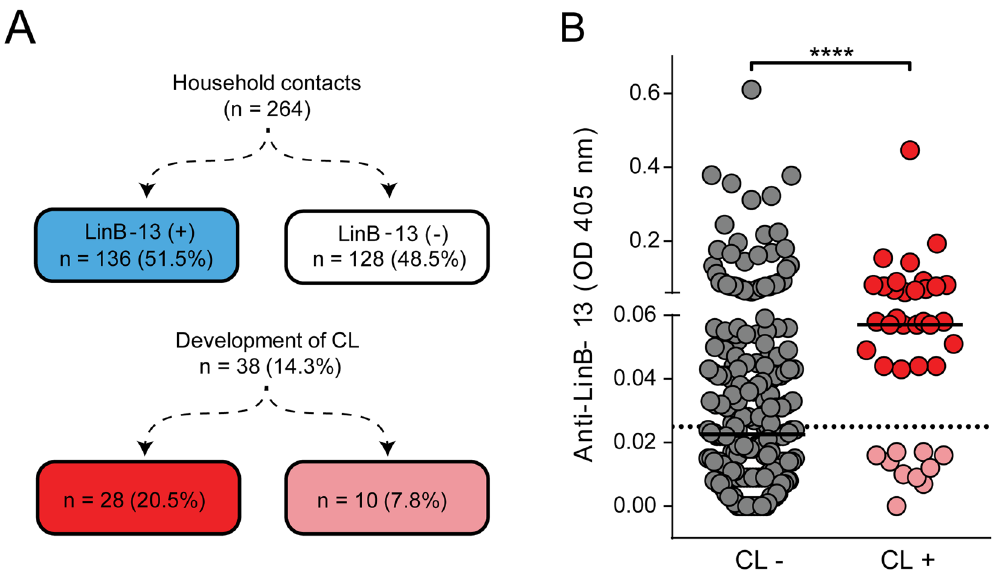
Figure 6. LinB-13 acts as risk factor for development of Cutaneous Leishmaniasis. ( A ) Total IgG response against LinB-13 was measured by ELISA in residents of a CL-endemic area who developed CL (n = 38) or who did not developed CL (n = 226). Data are shown individually. Black lines represent the median OD value for each antigen and dotted line represents the cut off value. ( B ) Flow chart showing the number of household contacts of CL patients who developed disease during the 5-year follow-up period, in both LinB-13 seropositive and seronegative individuals. **** P <